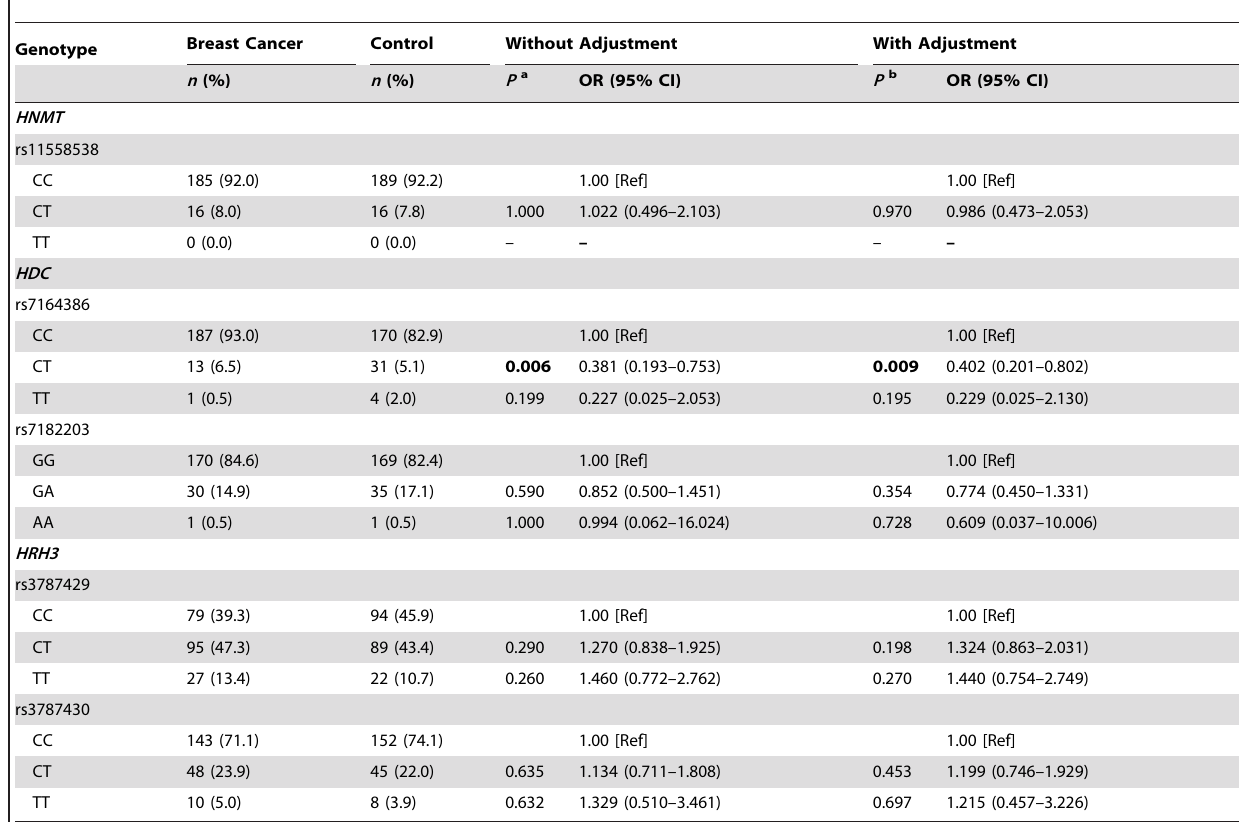
Table 2. Frequency distributions of HNMT , HDC and HRH3 genotypes and their associations with the risk of developing breast